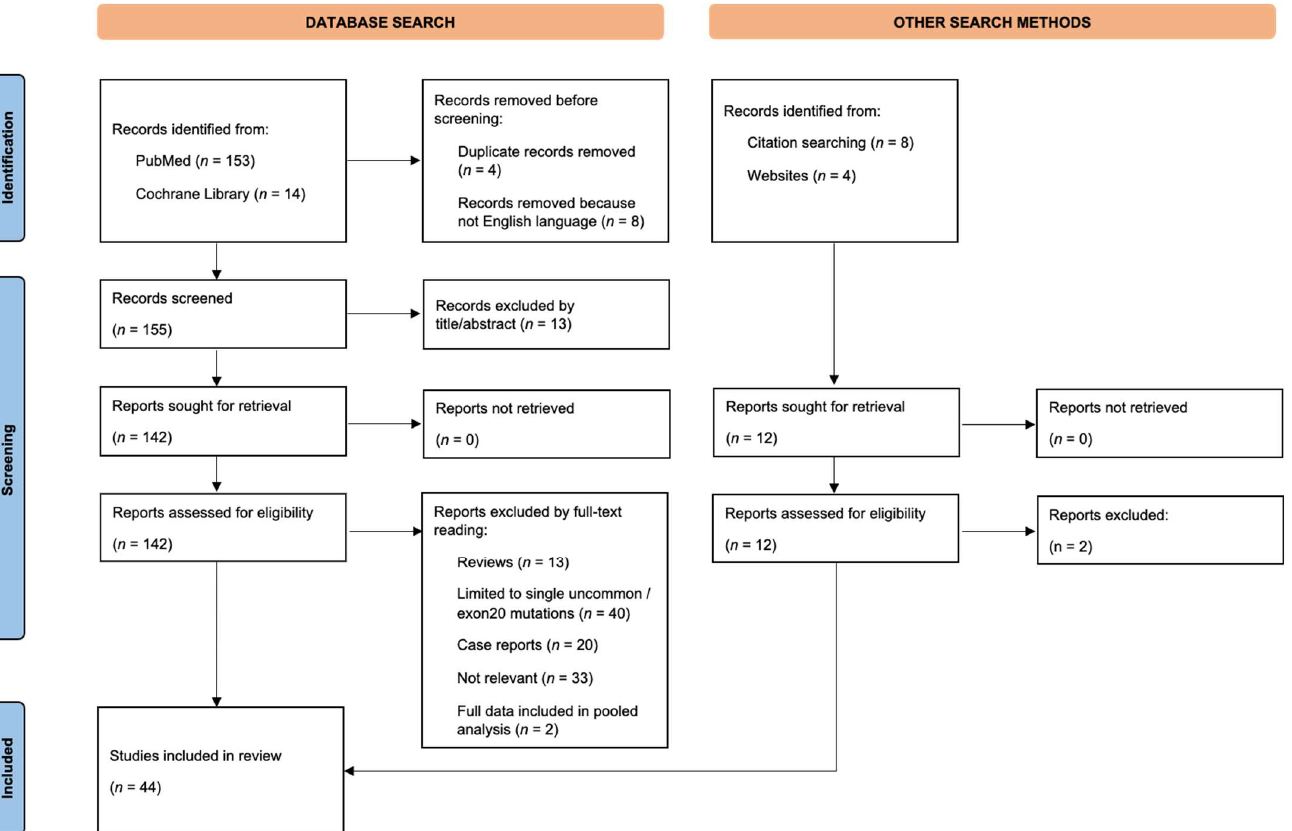
Figure 1. Flow diagram showing results for the systematic search performed using the search terms “uncommon”, “EGFR”, “compound”, “complex” and “lung cancer” in the time frame between January 2004 and October 2021.